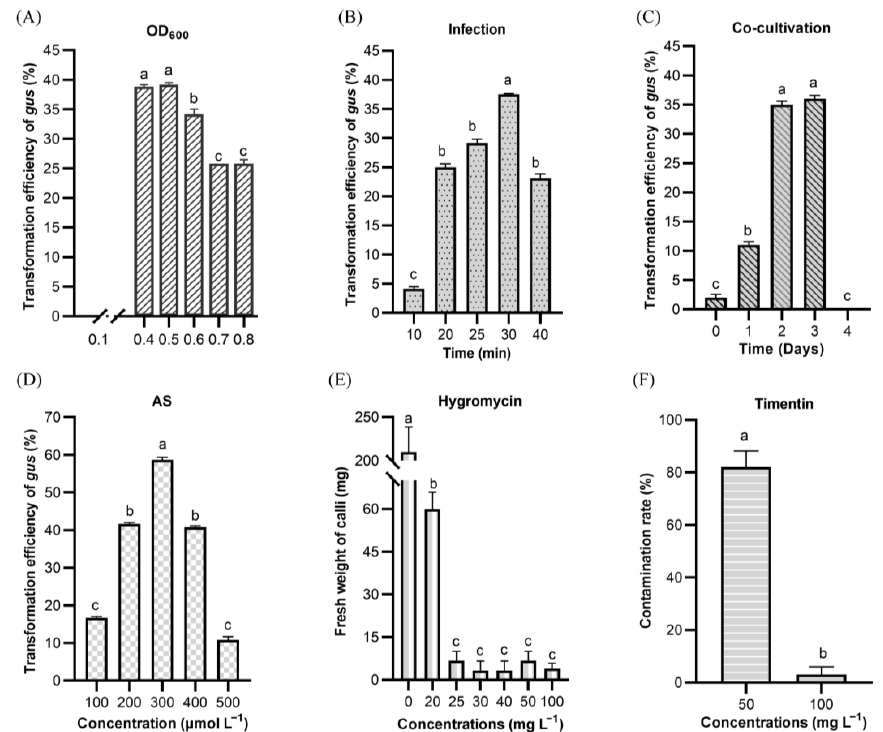
Figure 3. The determination of optimal regulators by Agrobacterium -mediated infection of goosegrass calli. ( A ) The effects of OD 600 of A. tumefaciens on the goosegrass calli showing gus expression. Different letters indicate significant differences at p < 0.05. ( B ) The impact of infection time on the goosegrass calli showing gus expression. ( C ) The effects of co-cultivation time on the goosegrass calli showing gus expression. ( D ) The effect of different acetosy- ringone (AS) concentrations in the co-cultivation on the transformation efficiency of the goosegrass calli. ( E ) Determination of hygromycin concentration for selecting HPT -positive goosegrass calli. The treatment without hygromycin (0) served as a negative control. ( F ) The effect of timentin as a suitable antibiotic for A. tumefaciens counter selection on goosegrass calli. Different letters indicate significant differences at p < 0.05.